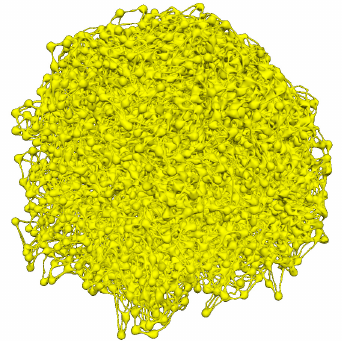
Figure 4. FRC network 3D model (for sphere with a diameter of about 200 µ